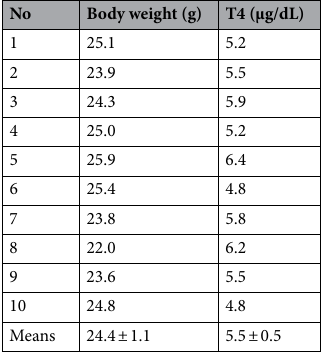
Table 1. Body weight of mice and thyroxine (T4) value before the start of the experiment.